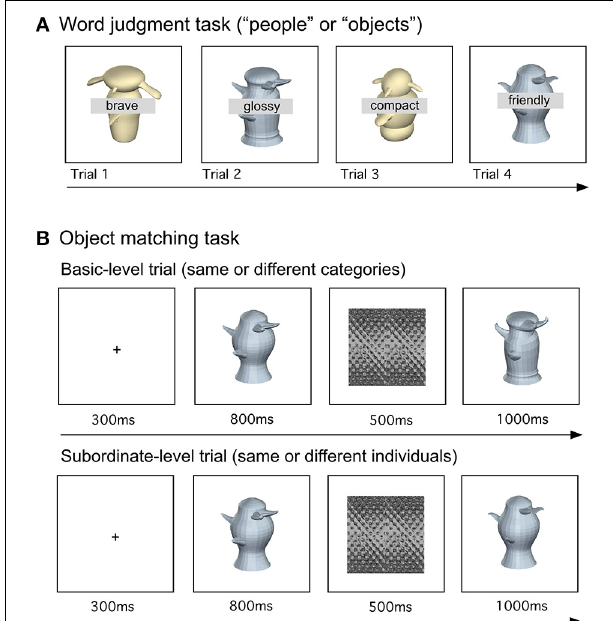
FIGURE 2 | Example trials of (A) the word judgment task and (B) the object matching task at the basic level (top: a basic-level trial with two individuals from different categories) and at the subordinate level (bottom: a subordinate-level trial with two individuals from the same